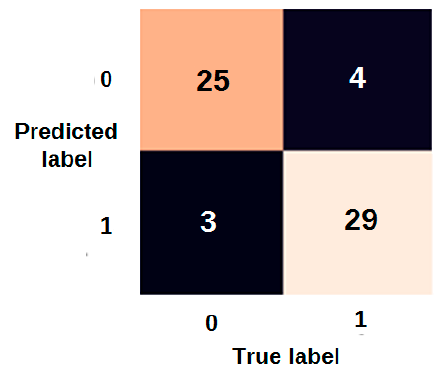
Figure 11. Confusion matrix. Using the logistic regression model we achieved the following classification report (Table